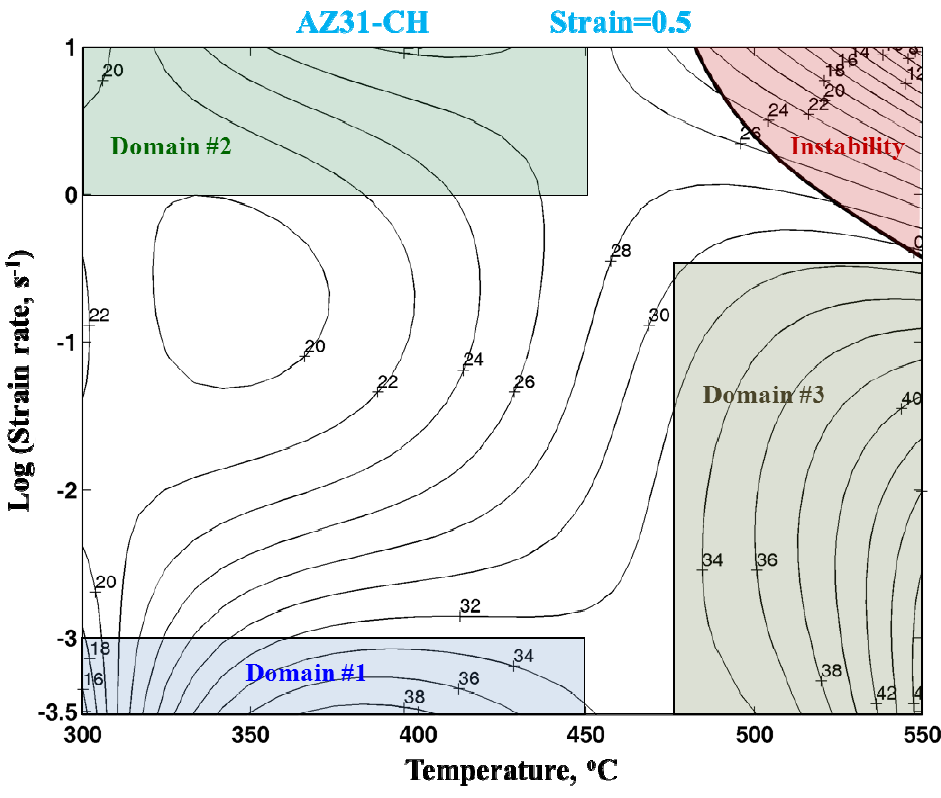
Figure 3. Processing map for AZ31 in cast-homogenized conditions (near-random texture) obtained at a strain of 0.5. The numbers against the contours represent efficiency of power dissipation in percent. The regime of flow instability is